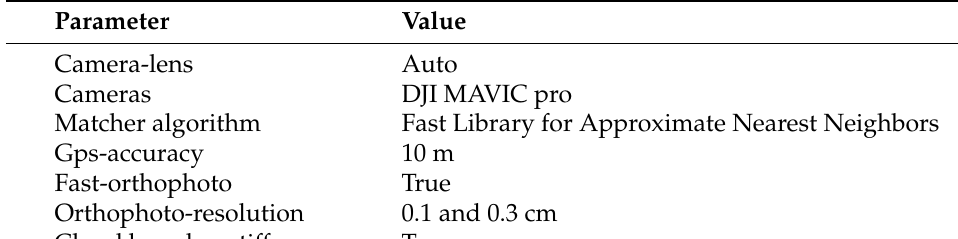
Table 2. OpenDroneMap detailed parameters.